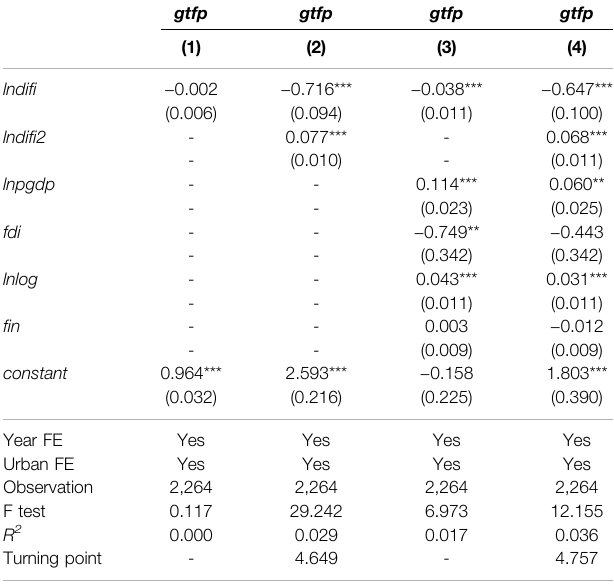
TABLE 3 | Benchmark regression